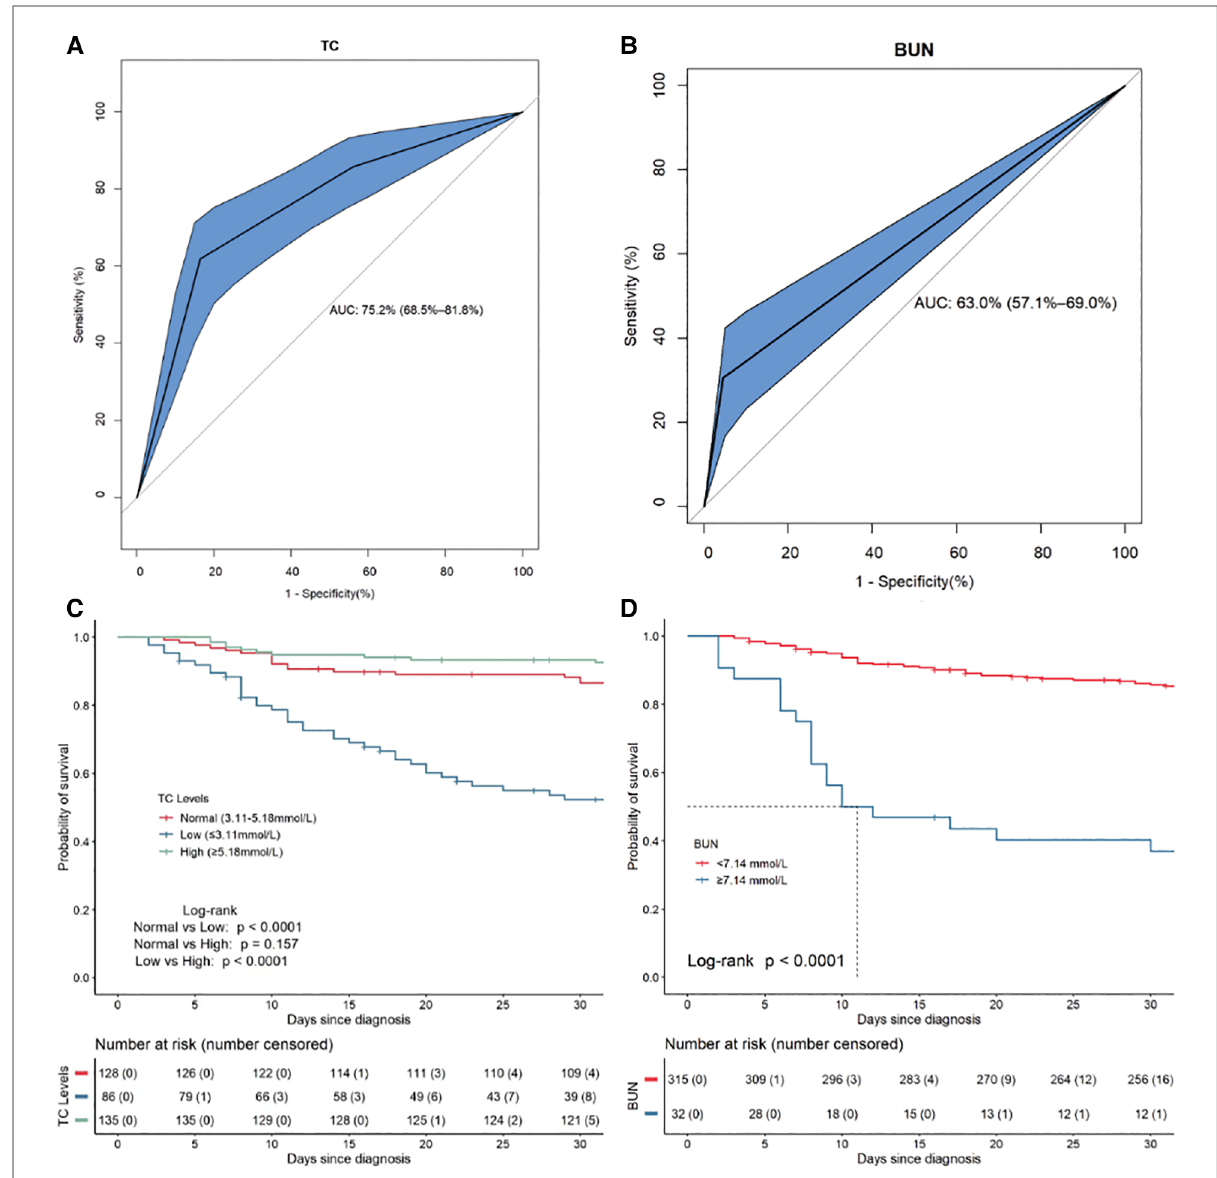
FIGURE 9 The ROC curves and Kaplan – Meier survival curves for the independent risk factors for 30-day mortality in 353 HLH patients. ( A ) The ROC plots for TC. ( B ) The ROC plots for BUN. ( C ) The Kaplan – Meier survival curves for subgroups of patients according to TC. ( D ) The Kaplan – Meier survival curves for subgroups of patients according to